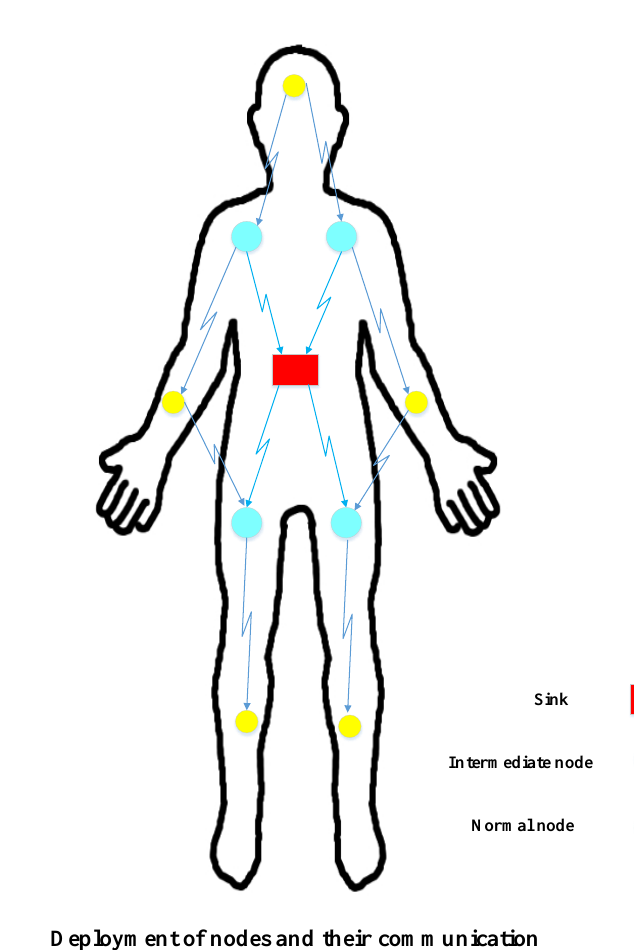
Figure 8. Placement and communication of nodes on the human